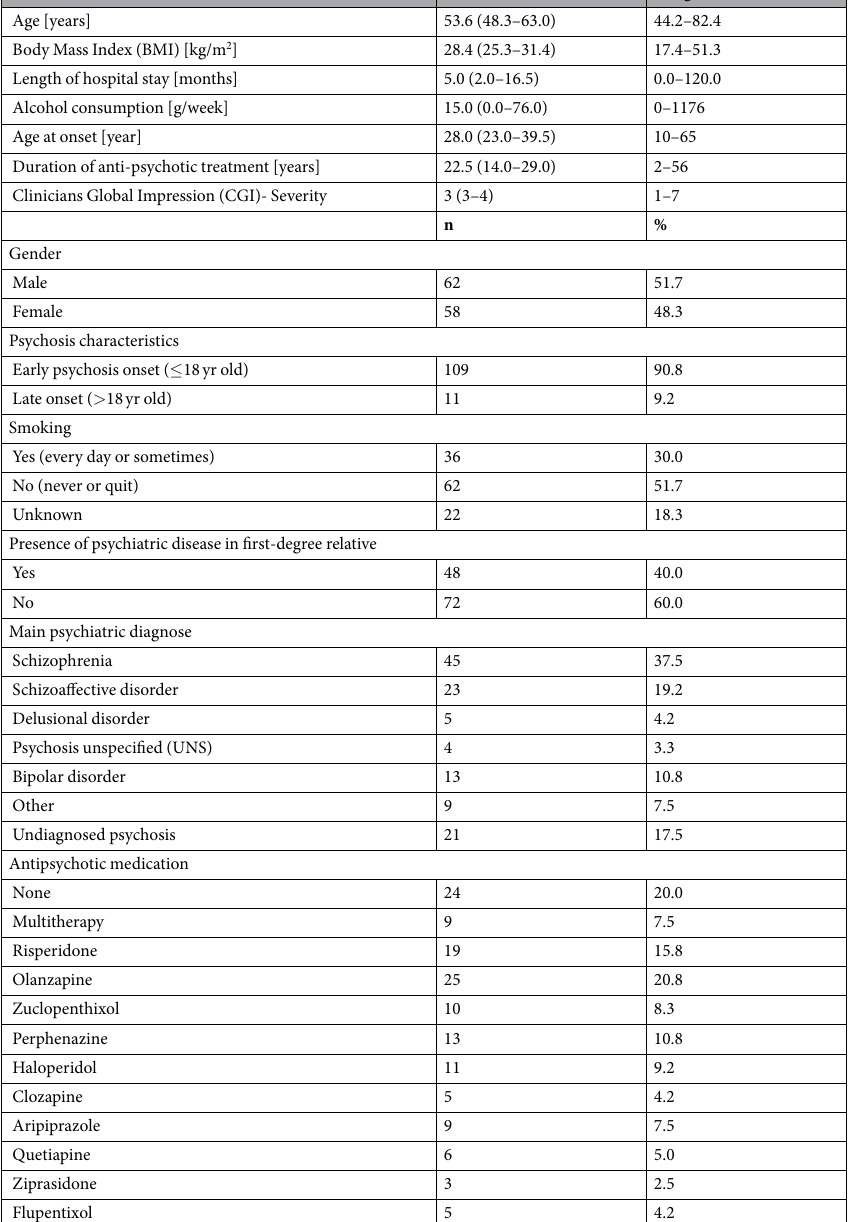
Table 1. Demographic and clinical characteristics of the psychosis patients (n =